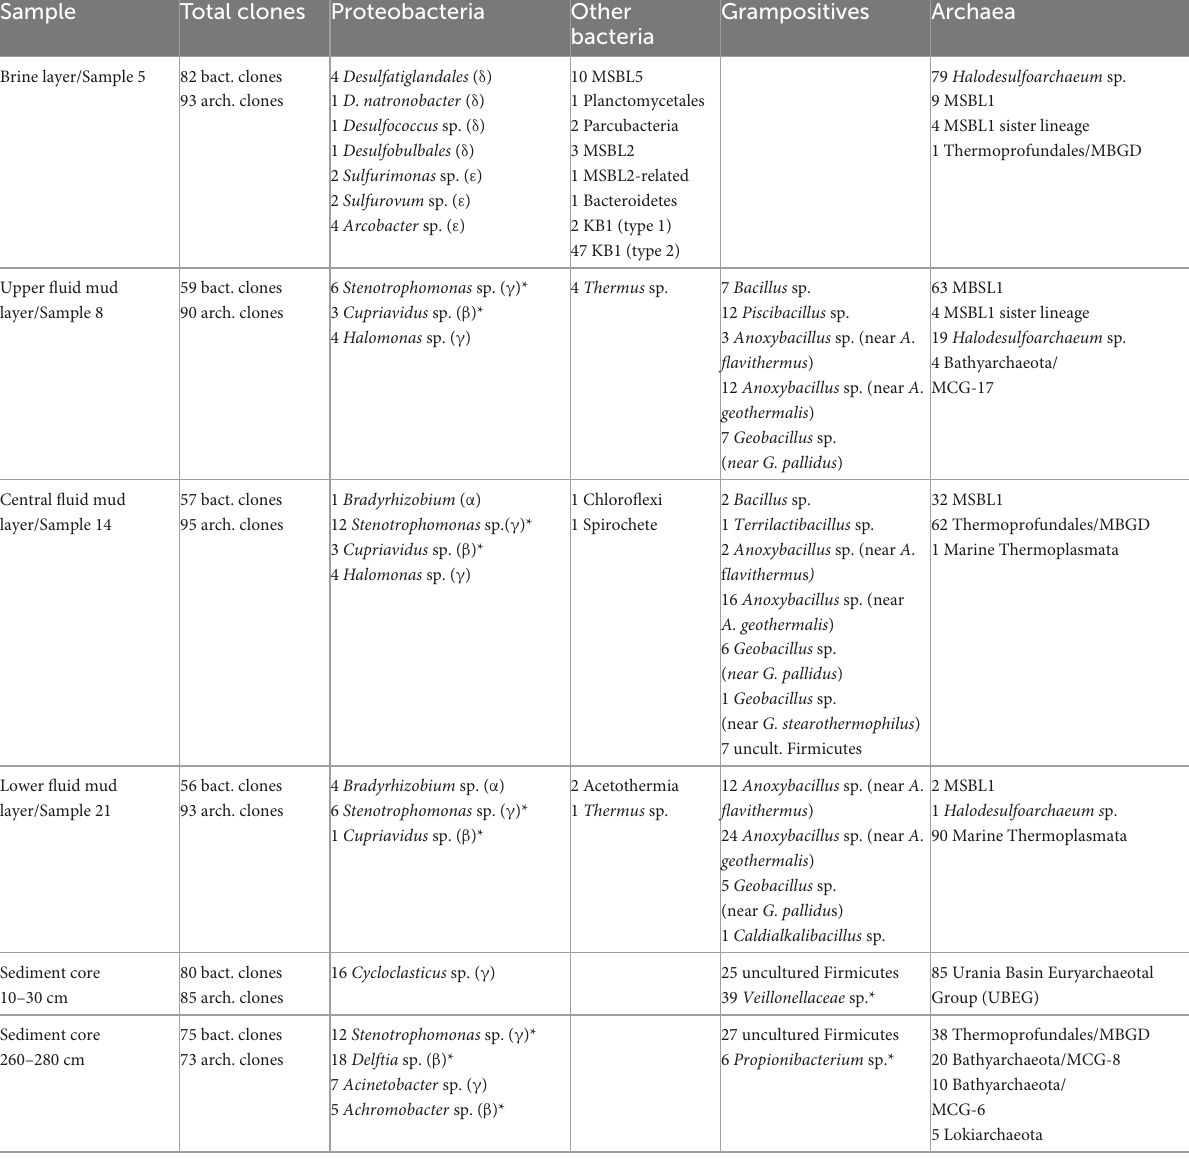
TABLE 1 Summary of Urania Basin 16S rRNA gene sequences and their phylogenetic affiliations based on Genbank searches for Bacteria and Archaea.